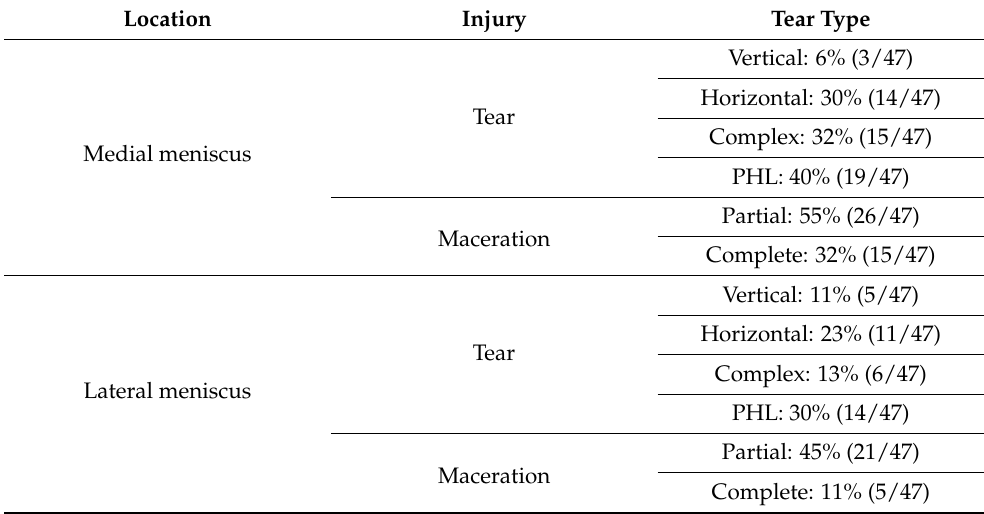
Figure 5. MOAKS outcome on baseline index knee MRI ( n = 47). (MCCW, medial compartment cartilage wear; LCCW, lateral compartment cartilage wear; PFCW, patella-femoral cartilage wear; BML, bone marrow lesions). Table 4. Baseline meniscus status of the index knees on MRI ( n = 47). Meniscus pathology was scored per part (anterior, body, or posterior